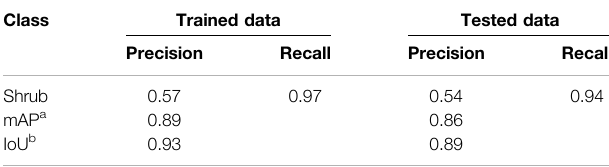
TABLE 3 | Shrub count accuracy assessment result. Class Trained data Tested data